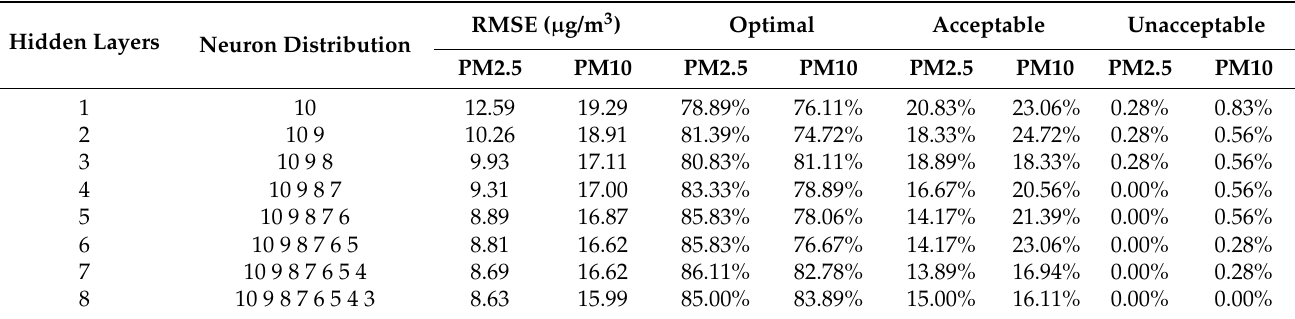
Table 5. Deep RNN model prediction results.